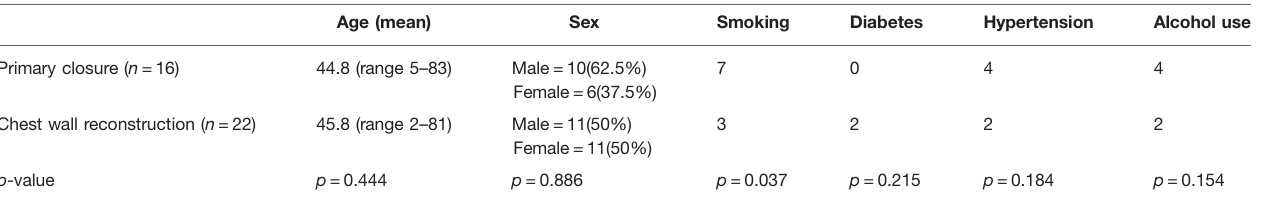
TABLE 1 | Patient demographics — primary closure vs. chest wall reconstruction (both MatrixRIB ™ implantation and prosthetic patch/autologous fl ap